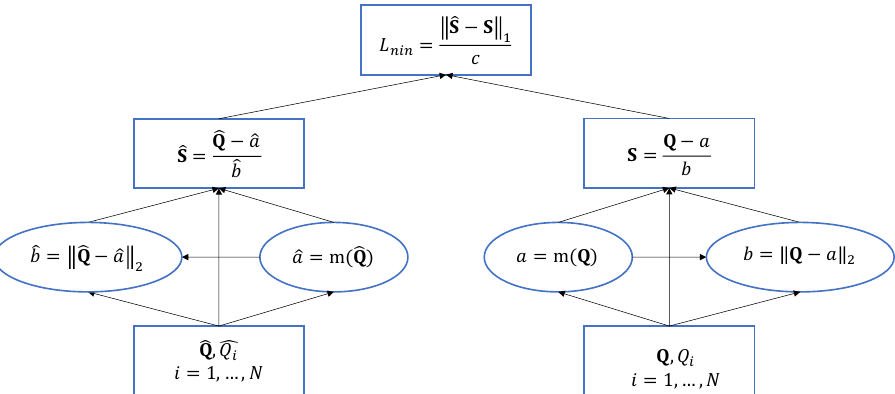
Figure 7. Illustration of the forward pass of the norm-in-norm loss [30]. Q and ˆQ are the Mean Opinion Score (MOS) and the predicted quality score vectors, respectively. m(·) denotes the mean function. c is a normalization term equal to 2 N 1 2